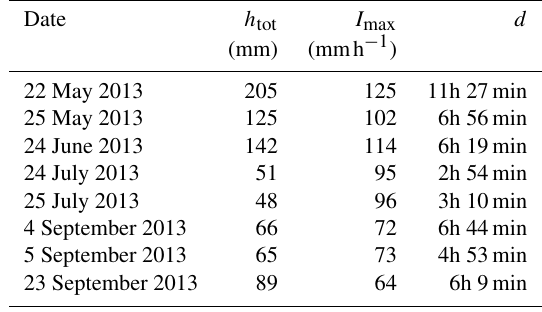
Table 2. Total rainfall depth ( h tot ), maximum 1min rainfall rate ( I max ) and duration ( d ) of selected events recorded by the Ogawa drop counter during the observation period.